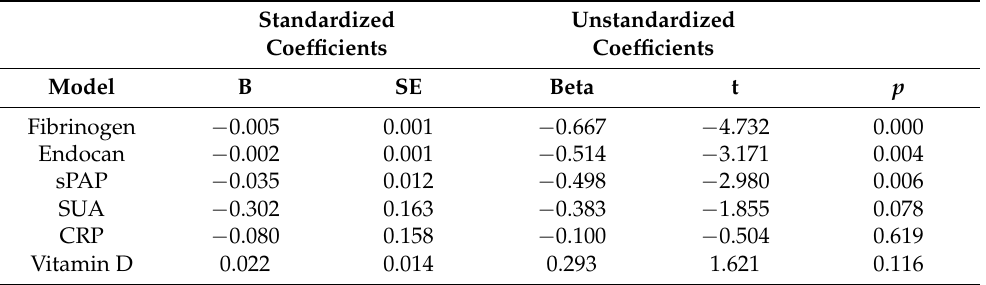
Table 3. Linear regression model.